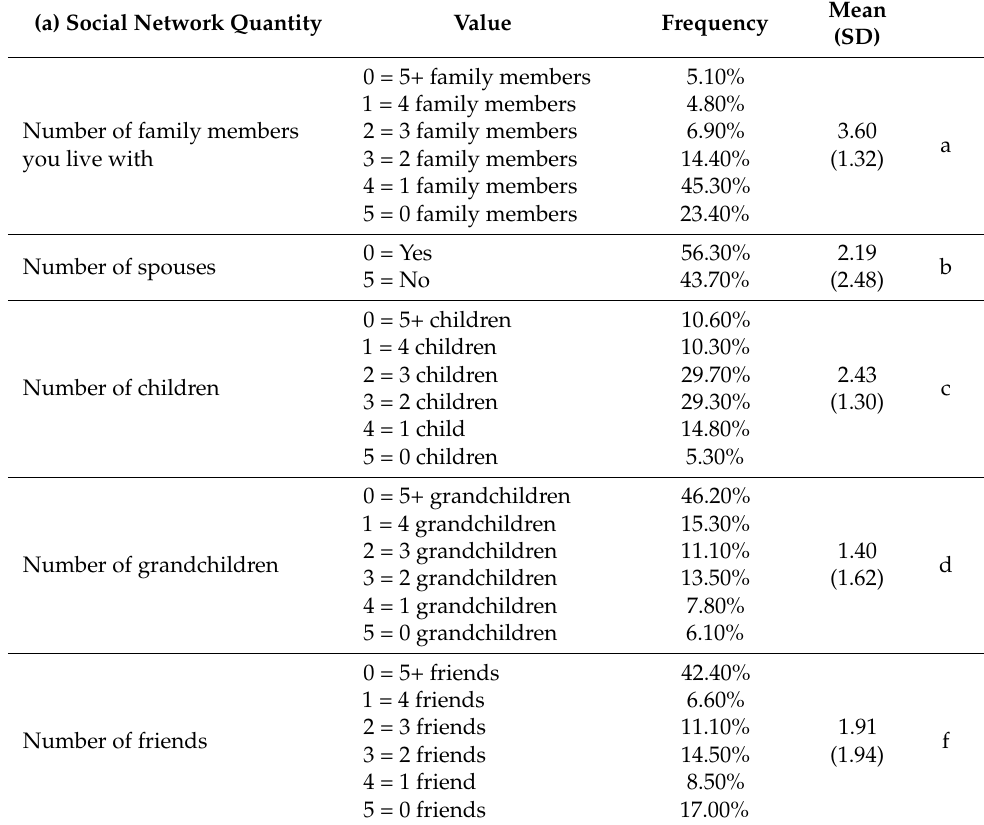
Table 1. Descriptive statistics and mapping scores for social isolation index